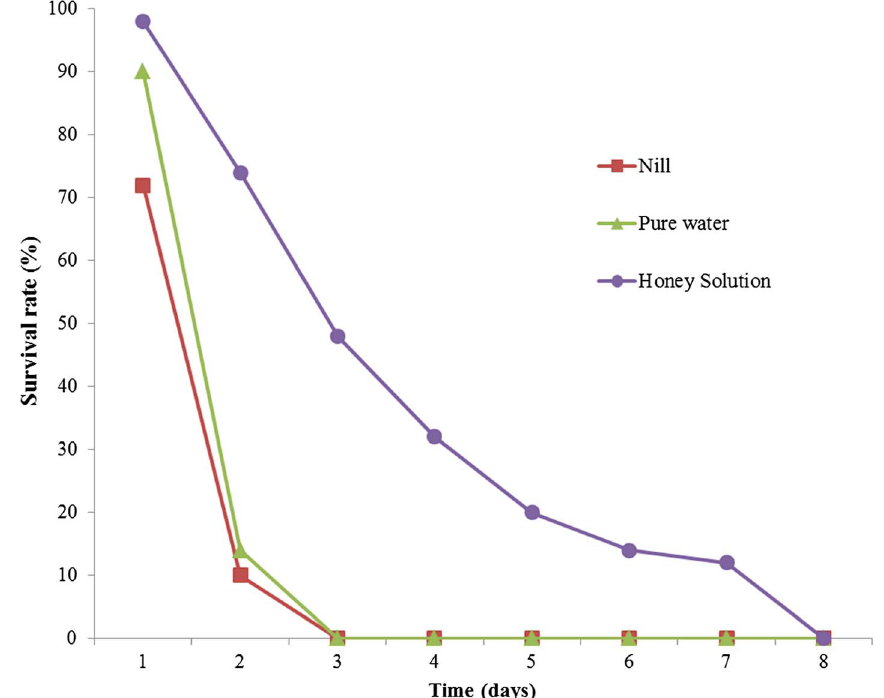
Figure 1. Survival patterns of female Quadrastichus mendeli fed on different diets.